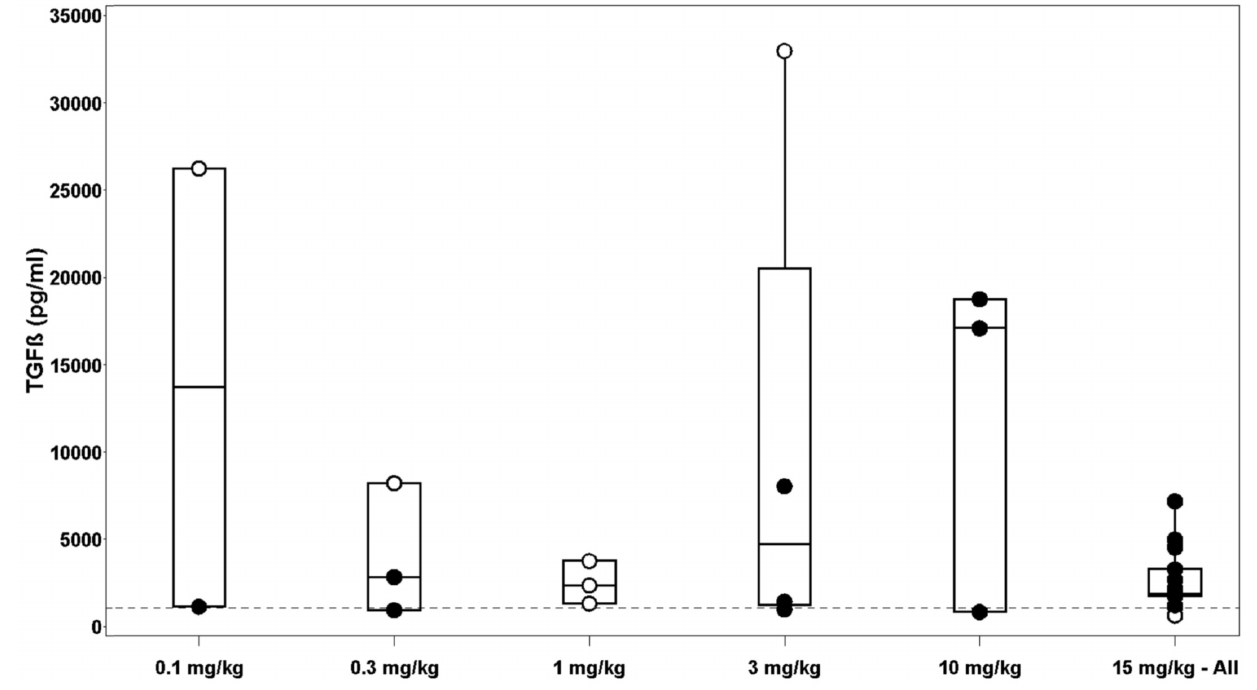
Figure 6. Pretreatment TGF b plasma levels. Measurements of total TGF b levels were performed on plasma using an ELISA assay. Boxplots of baseline levels of TGF b are displayed for each patient by cohort. The dashed line represents the normal range, as determined by 42 healthy donors with a mean 6 standard deviation of 1051 6 221 pg/mL. Open circles indicated baseline levels of patients who achieved a PR or SD.